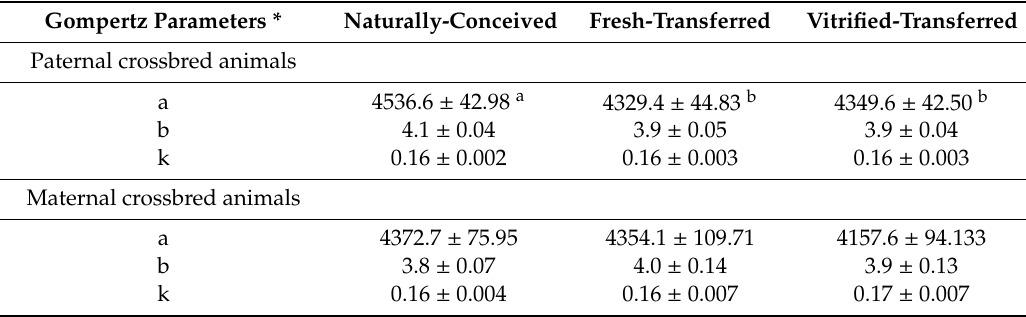
Gompertz parameters of the naturally conceived (NC), fresh-transferred (FT), and vitrified-transferred (VT) progenies of the paternal crossbred generation and maternal crossbred